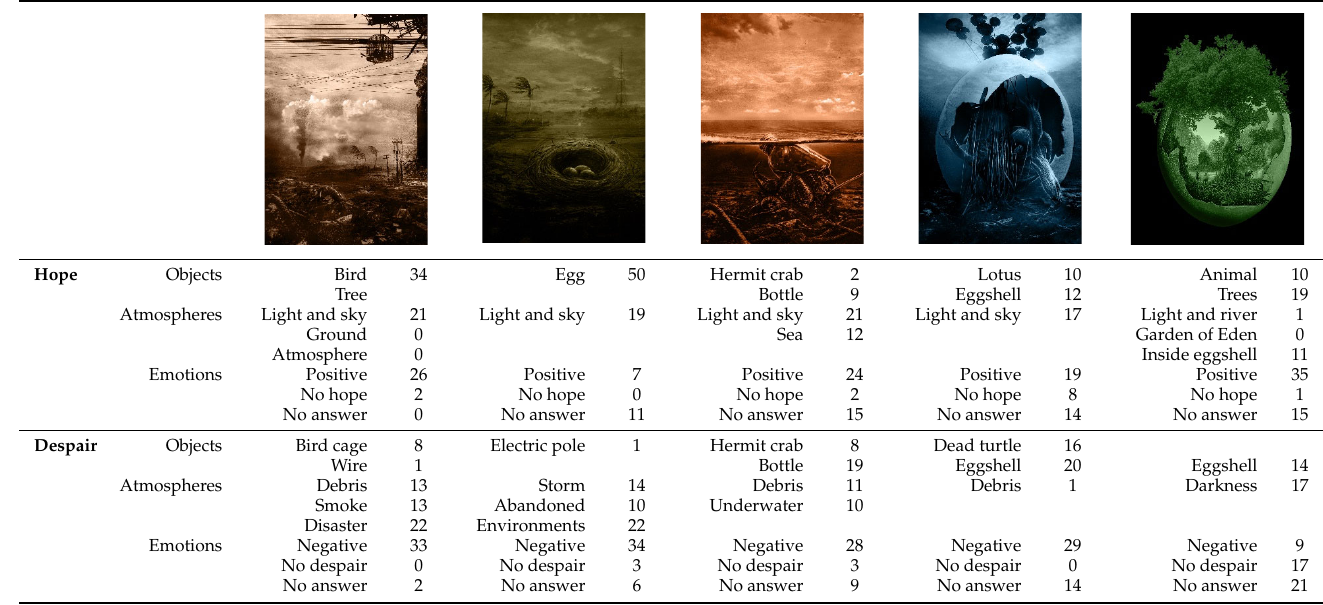
Table 4. Amount of comments on monochrome images expressing hope and